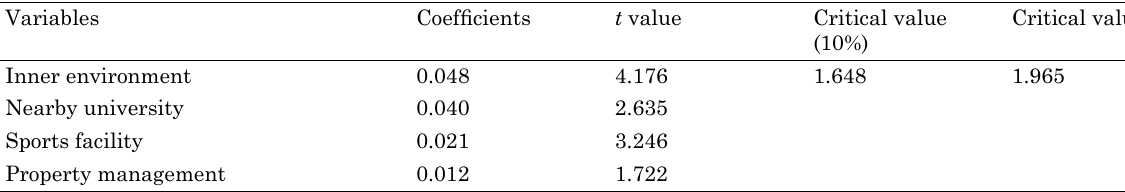
Table 5. Regression results for global variables